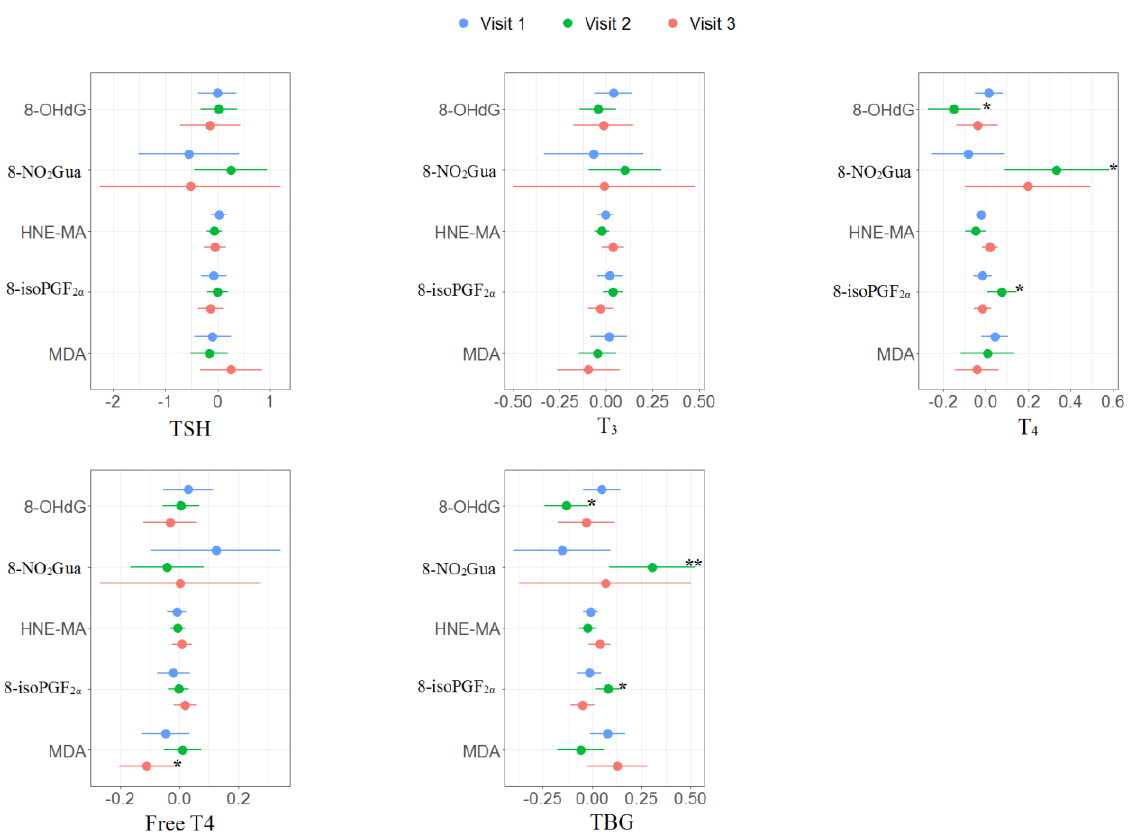
Figure 2. Unit change in oxidative/nitrosative stress biomarkers concentrations in association with concentrations of thyroid hormones across three visits. Multiple linear regressions are adjusted for age and creatinine; * p < 0.05, ** p < 0.01, *** p < 0.001. For the associations between thyroid hormone ratios and oxidative or nitrosative stress biomarkers, MDA was negatively associated with free T 4 to TBG ratio ( β : − 0.12, 95% CI [ − 0.24 to − 0.01]) in the first trimester. For the second trimester, 8-OHdG was negatively associated with T 4 to free T 4 ratio ( β : − 0.15, 95% CI [ − 0.28 to − 0.03]); 8-NO 2 Gua was positively associated with T 4 to free T 4 ratio ( β : 0.37, 95% CI [0.13 to 0.62]) but negatively associated with free T 4 to TBG ratio ( β : − 0.35, 95% CI [ − 0.64 to − 0.07]); 8-isoPGF 2 α was positively associated with T 4 to free T 4 ratio ( β : 0.08, 95% CI [0.01 to 0.15]) but negatively associated with free T 4 to TBG ratio ( β : − 0.09, 95% CI [ − 0.18 to − 0.01]). For the third trimester, MDA was negatively associated with free T 4 to TBG ratio ( β : − 0.24, 95% CI [ − 0.42 to − 0.05]) (Supplementary Tables S3–S5 and Figure 3).